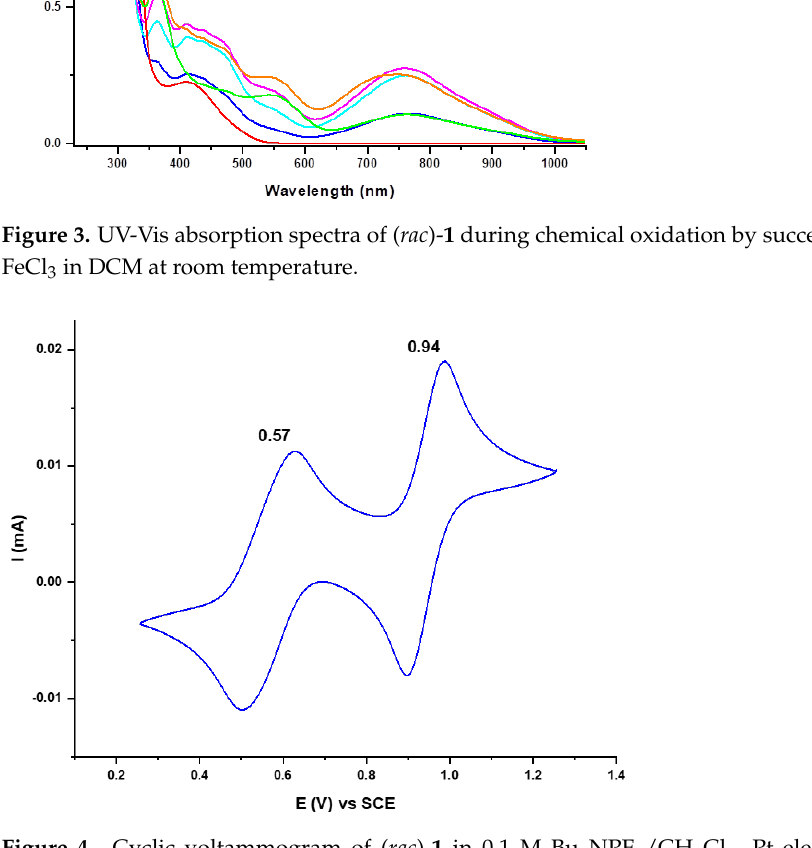
Figure 4. Cyclic voltammogram of ( rac )- 1 in 0.1 M Bu 4 NPF 6 /CH 2 Cl 2 , Pt electrode, scan rate 100 mV s −1 . The E 1/2 values are shown for both reversible peaks.